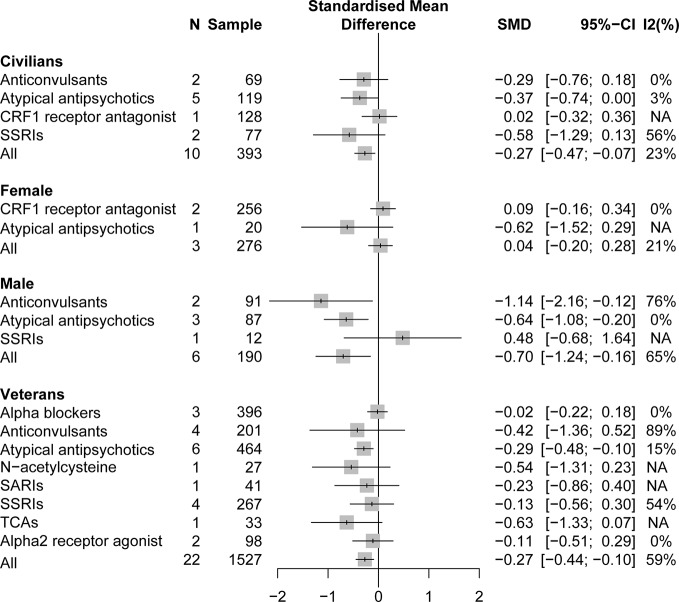
Forest plot based on stratified analyses of different populations and gender of placebo-controlled comparisons. TCAs, tricyclic antidepressants.